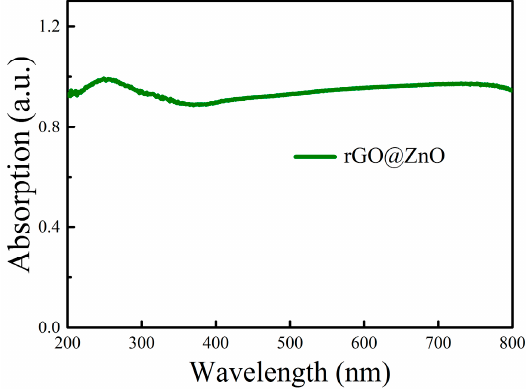
Figure 3. UV-Vis spectra of the pure ZnO and rGO@ZnO 1 − x